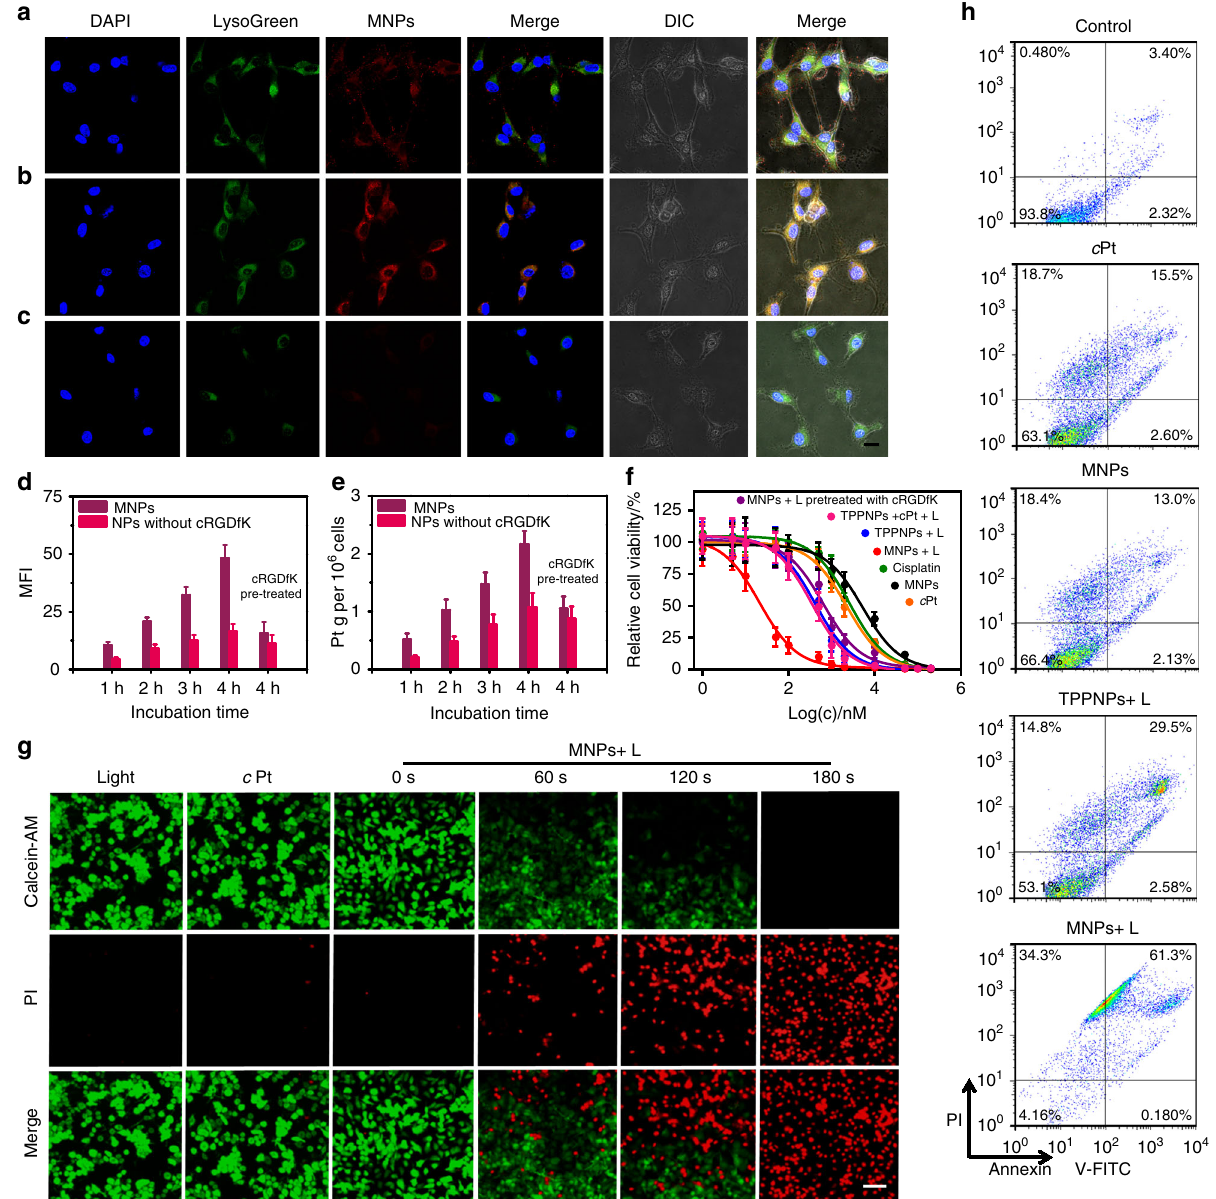
Fig. 3 In vitro targeted delivery activity of the MNPs and synergistic anticancer effect. CLSM images of U87MG cells cultured with MNPs for a 2 h, b 4 h, and c 4 h pre-treated with free cRGDfK for 30 min. Scale bar is 20 μ M. d Mean fl uorescent intensity (MFI) and e intracellular platinum amount of U87MG cells after treatment with the MNPs or NPs without cRGDfK for different incubation times. f Cytotoxicity of U87MG cells treated with different administrations. g Fluorescence images of U87MG cells co-stained with Calcein AM/PI after different treatments. The platinum concentration of c Pt and MNPs was kept at 200 nm. Scale bar is 50 μ M. h FCM analysis of U87MG cell apoptosis induced by different treatments. The irradiation density was 0.1 W cm – 2 at 671 nm, and the irradiation time was 3 min. The data are expressed as means ±